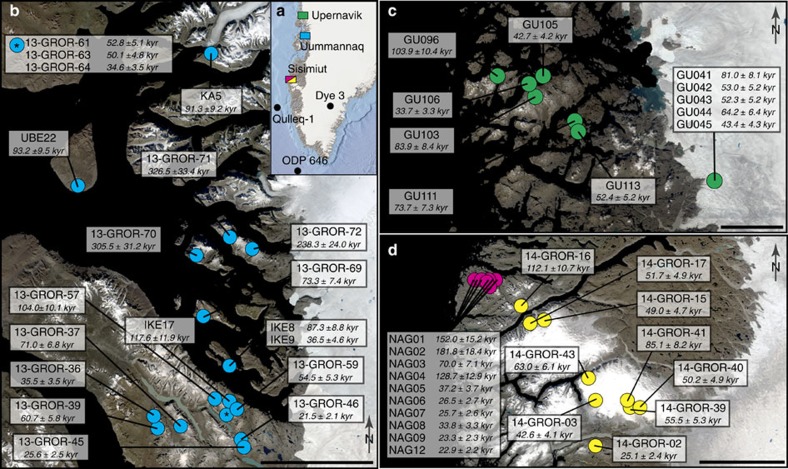
Overview maps of sample sites and simple exposure
10Be ages.(a) South Greenland overview with coloured boxes marking the four TCN sample sites and black circles marking points of pre-LGM Quaternary data5736. (b) Uummannaq area with sample sites containing 10Be and 26Al bedrock data19. The point marked with an asterisk represents 3 sample sites, which are shown in the top left box. The scale bar is 50 km wide. (c) Sample sites with 10Be and 26Al bedrock data202425 from the Upernavik area. The scale bar is 25 km wide. (d) Sisimiut area, covering samples from two sites; the inter-fjord site Itilleq26 (red) and samples from the margins of the local ice cap Sukkertoppen20 (yellow). The scale bar is 50 km wide. The data points shown in (b–d) meet the criteria of being applicable to the MCMC model approach, by having simple exposure 10Be ages above 20 kyr and a 26Al/10Be ratio below 7.5. (b–d) Simple exposure 10Be ages are calculated using Cronus Version 2.3 (ref. 45) and the Lal (1991)/Stone (2000) scaling scheme4041. Figure 1 was created using QGIS software46. All satellite images are from Landsat8, August 2016, courtesy of the U.S. Geological Survey.